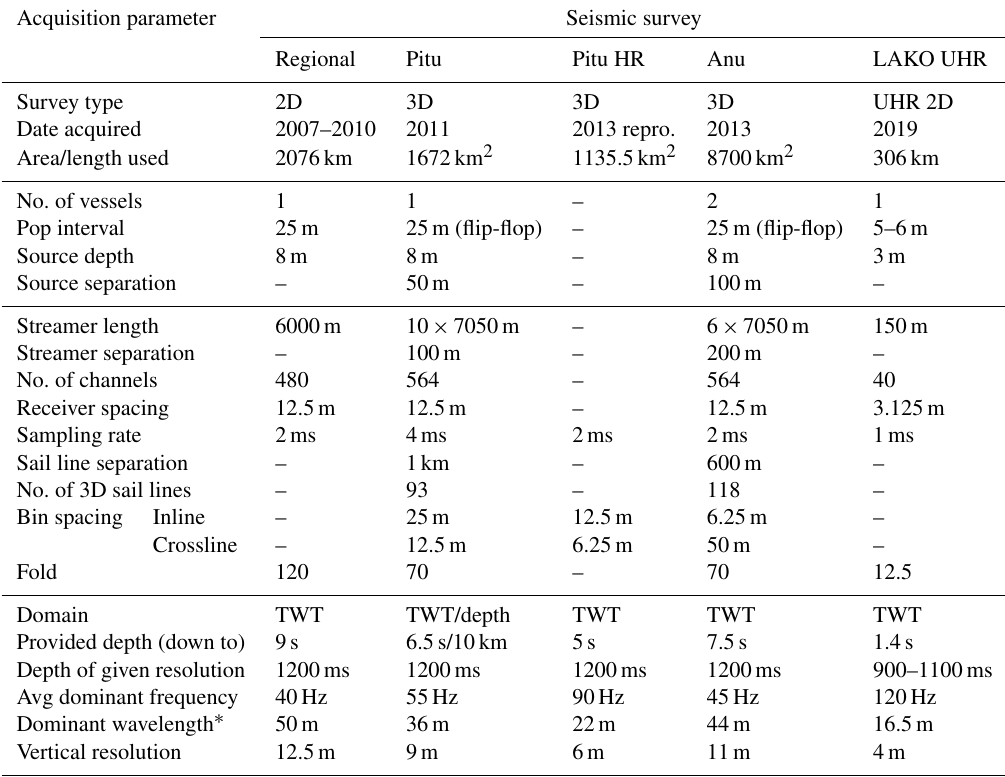
Table 2. Acquisition parameters and survey statistics for the four seismic surveys used within this study. A dash (–) represents a parameter that is not applicable for that survey. The Pitu HR parameters can be read from the Pitu survey. Abbreviations used within the table include two-dimensional (2D), three-dimensional (3D), ultra-high-resolution (UHR), reprocessed (repro.), number (No.), average (Avg) and two-way time (TWT). Units used include metres (m), kilometres (km), milliseconds (ms), seconds (s) and hertz